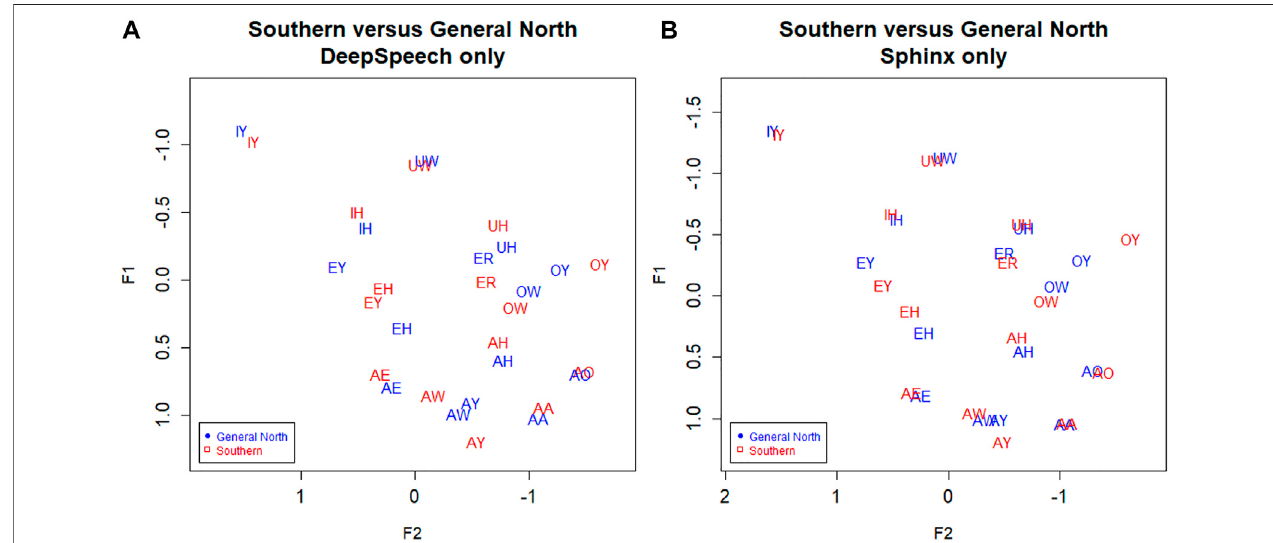
FIGURE 6 | Southern versus General North. Red: General North, Red: Southern. (A) DeepSpeech ASR, speaker vowel means. 330 speakers, 24,295 tokens. (B ) CMU Sphinx ASR, speaker vowel means. 330 speakers, 27,637 tokens. Plotted in Lobanov-normalized units.